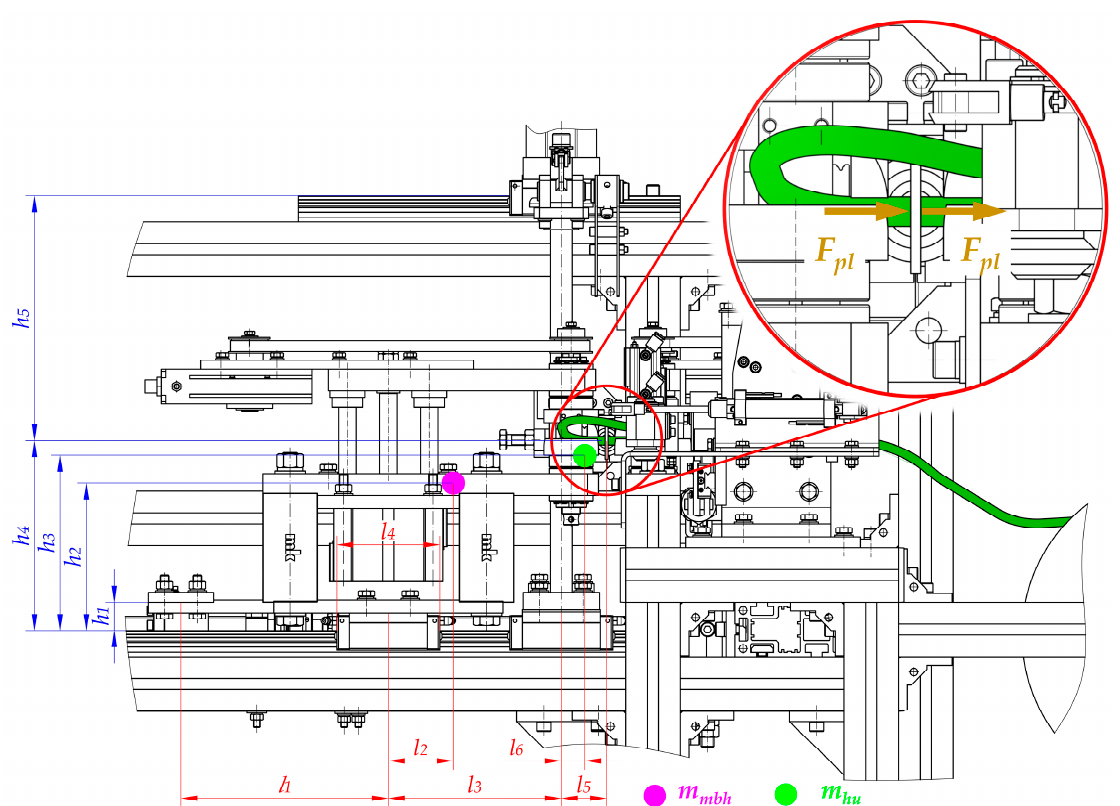
Figure 9. Horizontal view in a plane parallel to the linear guideways, of the automated hot plate welder during plasticization, with the particular dimensions which are necessary for the load state calculations: m mbh —center of mass of the movable belt holder, m hu —center of mass of the heating unit, F pl —plasticization force; l 1 …l 6 —particular values of length, h 1 …h 5 —particular values of height.